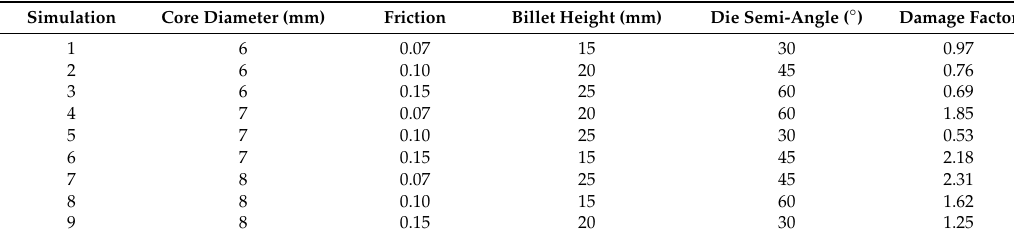
Table 14. Taguchi’s orthogonal array for damage factor.